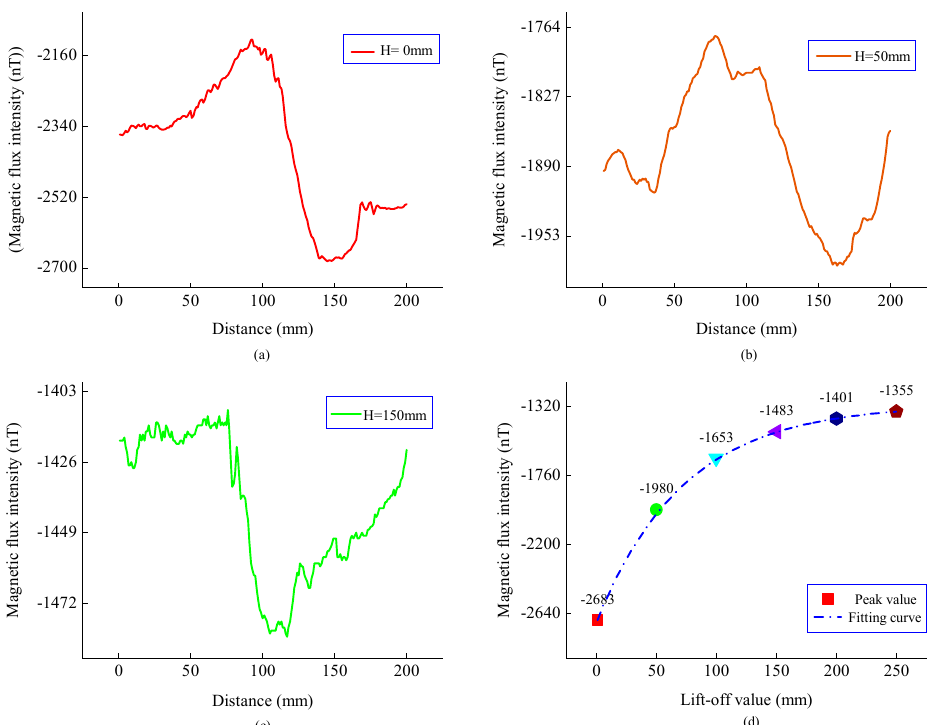
Figure 13. Normal components and the peak curve of the magnetic flux intensity at different lift-offs. ( a ) Normal components when H is 0 mm. ( b ) Normal components when H is 50 mm. ( c ) Normal components when H is 150 mm. ( d ) Peak and fitting curve.